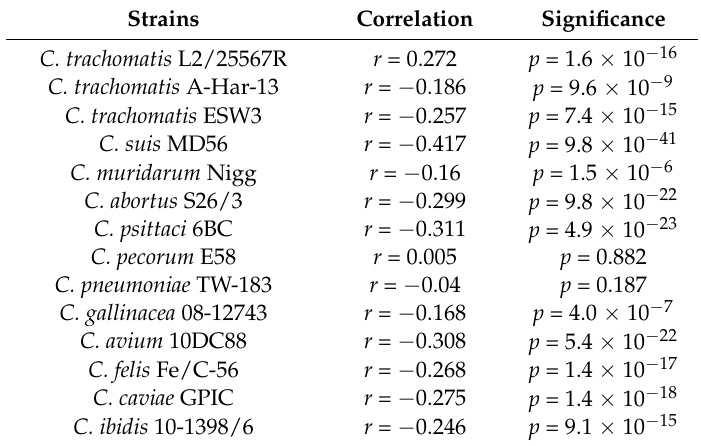
Table 3. The correlation between the codon adaptiation index (CAI) and ENC of Chlamydia spp.